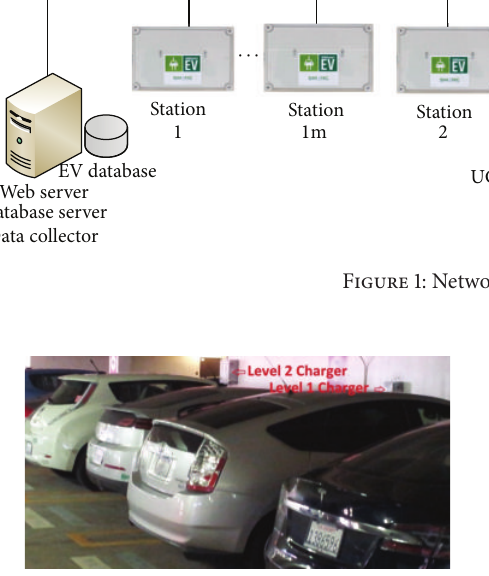
Figure 2: Installation of smart charging